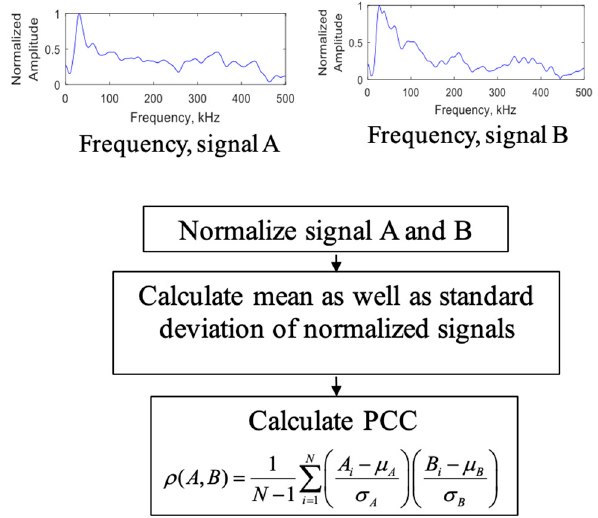
Figure 20. Procedure for obtaining the Pearson correlation coefficient of frequency spectra of two time-domain signals.